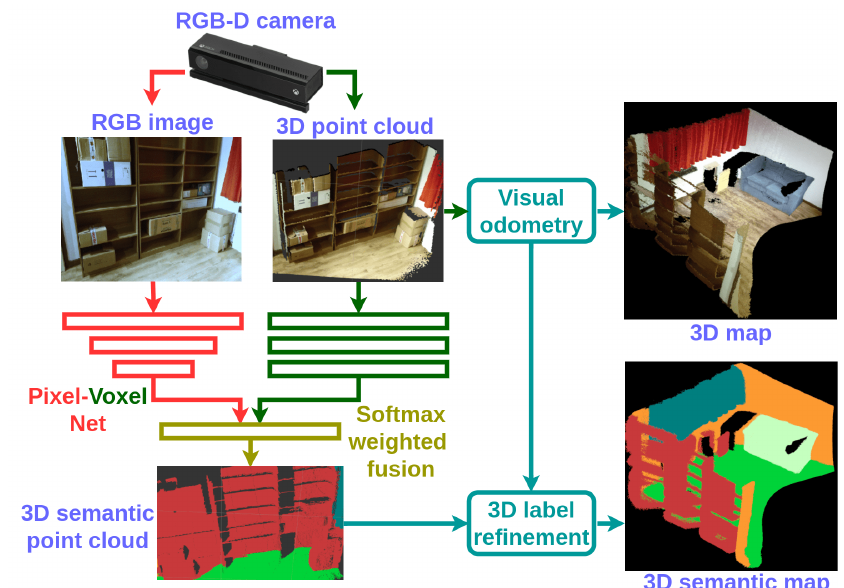
Figure 1. The pipeline of the proposed dense RGB-D semantic mapping with the Pixel-Voxel neural network. The RGB image and 3D point cloud are obtained from an RGB-D camera, Kinect V2. The RGB and point cloud data-pair of each key-frame is fed into the Pixel-Voxel network for semantic segmentation. The semantically-labelled point clouds are then combined incrementally through the visual odometry of RGB-D SLAM. The label probability of each voxel is further refined by a recursive Bayesian update. Finally, the dense 3D semantic map is